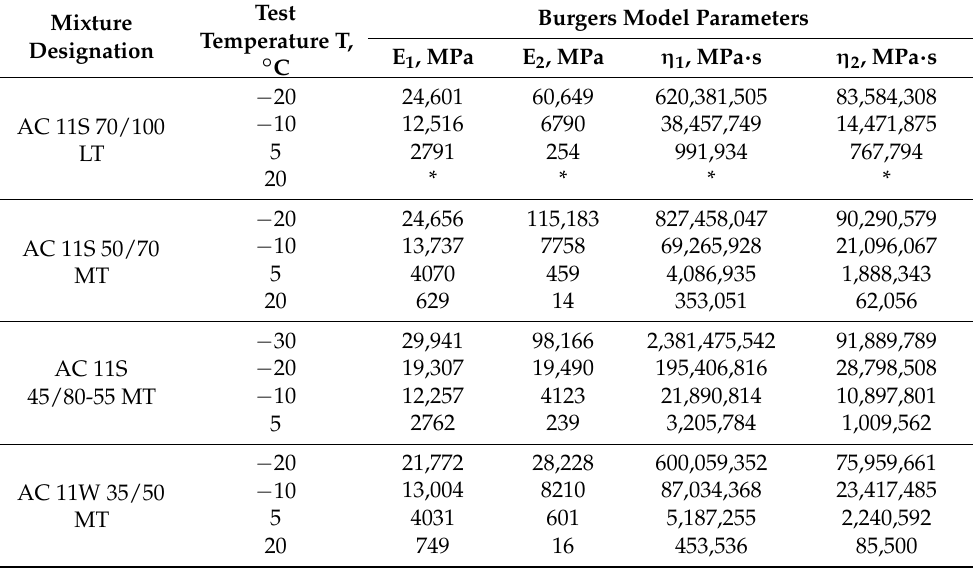
Table 4. Burgers’ model parameters for the Tensile Creep Test (TCT)